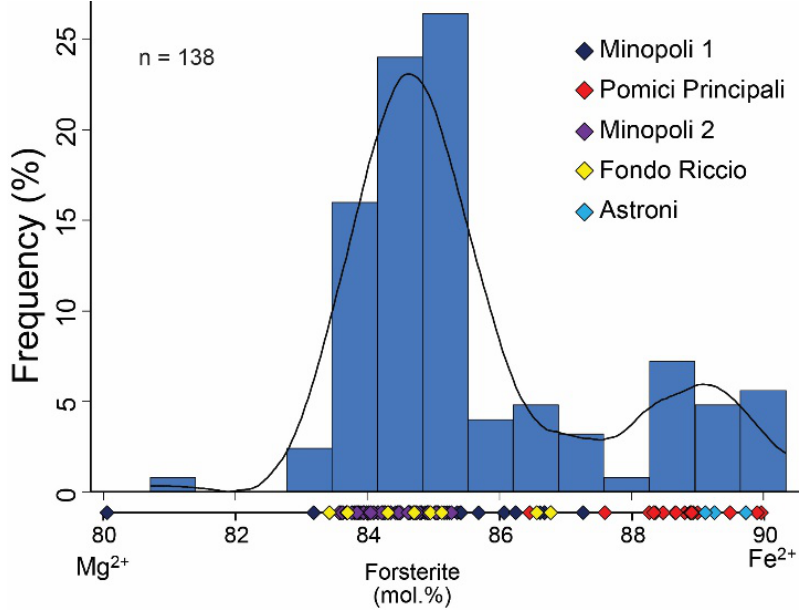
Figure 3. Forsterite (mol %) contents of the Campi Flegrei olivine and Fo (mol %) frequency histogram showing the distribution of olivine compositions.